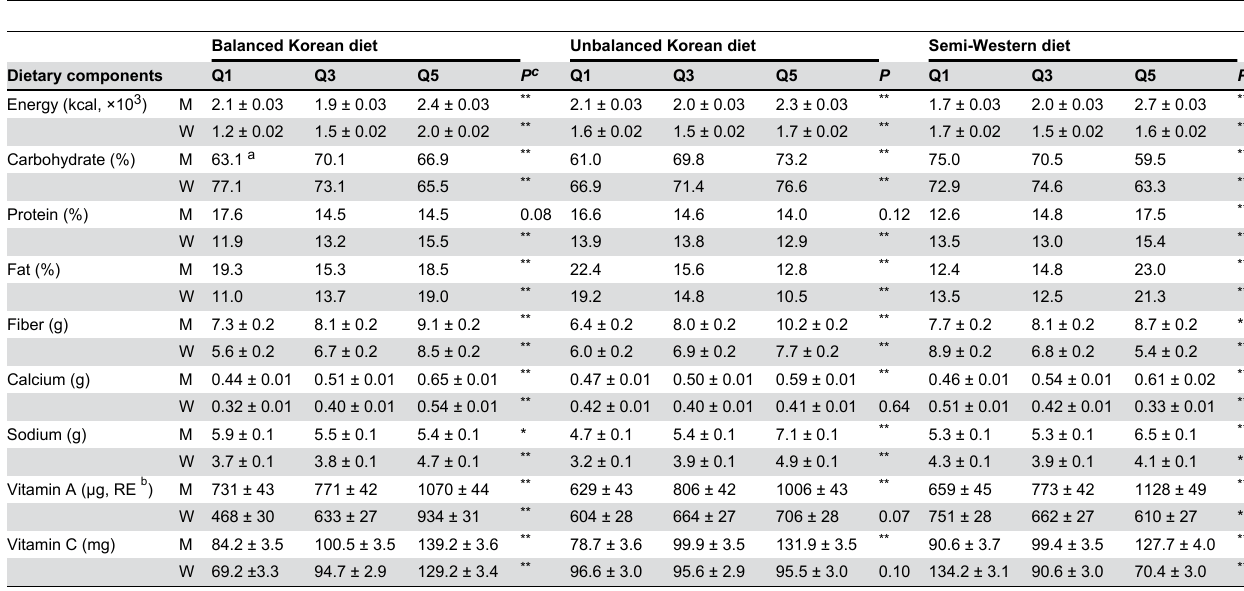
Table 1. Dietary compositions by the quintiles of major three Korean diets based on the KNANES 2007-2008 (n=5,320, 2,239 men and 3,081 women).